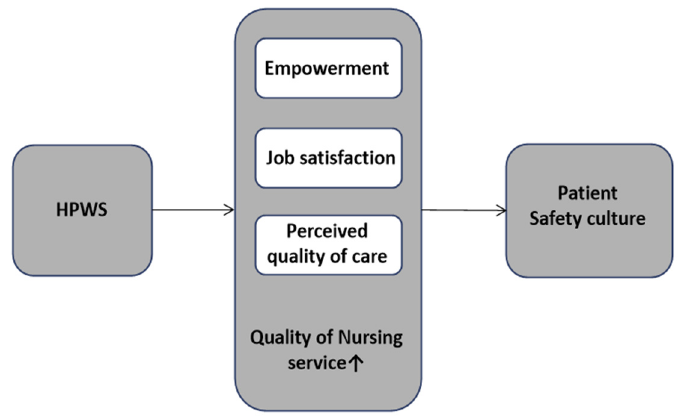
Figure 1. Conceptual framework from the literature review.